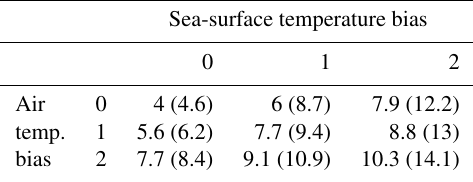
Table 2. Mass loss in sea-level equivalent metres from the simu- lated Pliocene Antarctic ice sheet after 10kyr, using environmental conditions from the regional climate model and augmented with a range of air and ocean temperature bias corrections. Numbers in parentheses represent duplicate experiments in which a more ag- gressive grounding-line scheme is employed (see